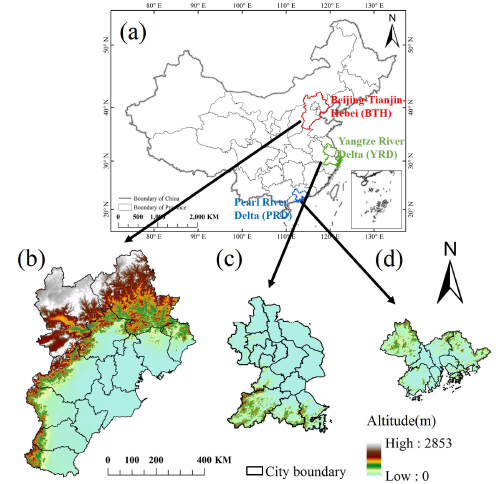
Figure 1. Geographical location ( a ) and topographical setting of Beijing-Tianjin-Hebei ( b ), Yangtze River Delta ( c ), and Pearl River Delta ( d ).